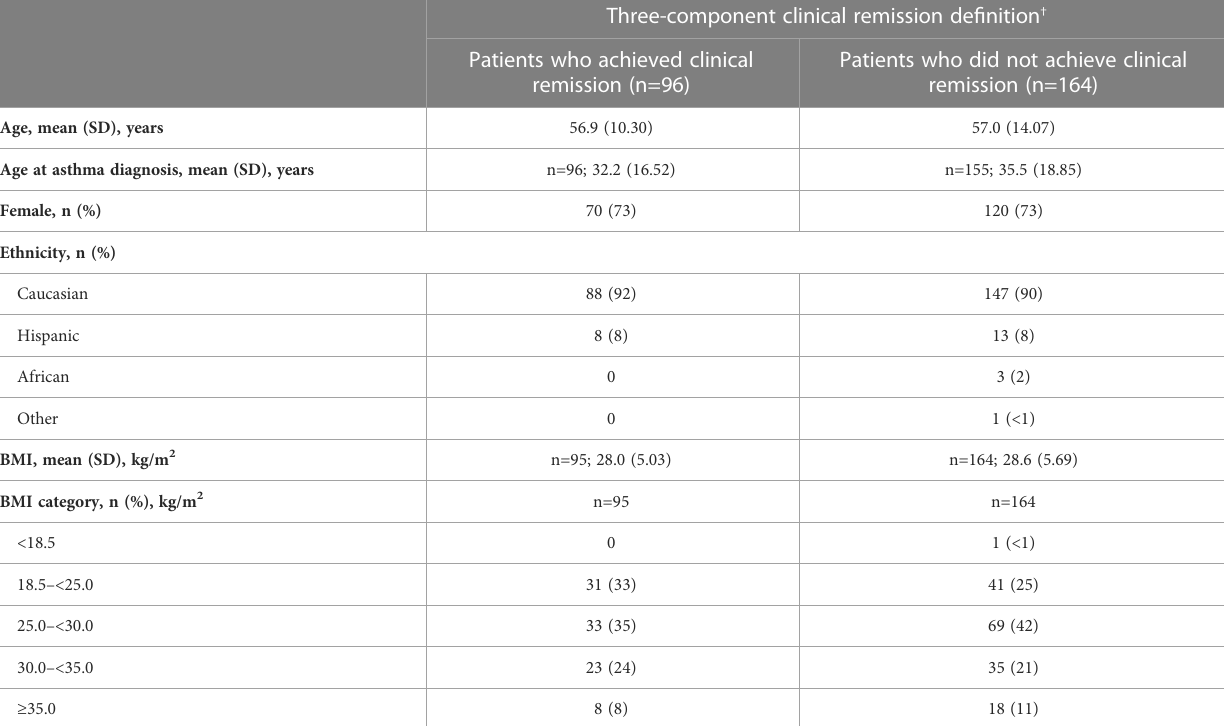
TABLE 2 Patient baseline demographics and clinical characteristics in those who did/did not meet the three-component de fi nition of clinical remission following 1 year of mepolizumab